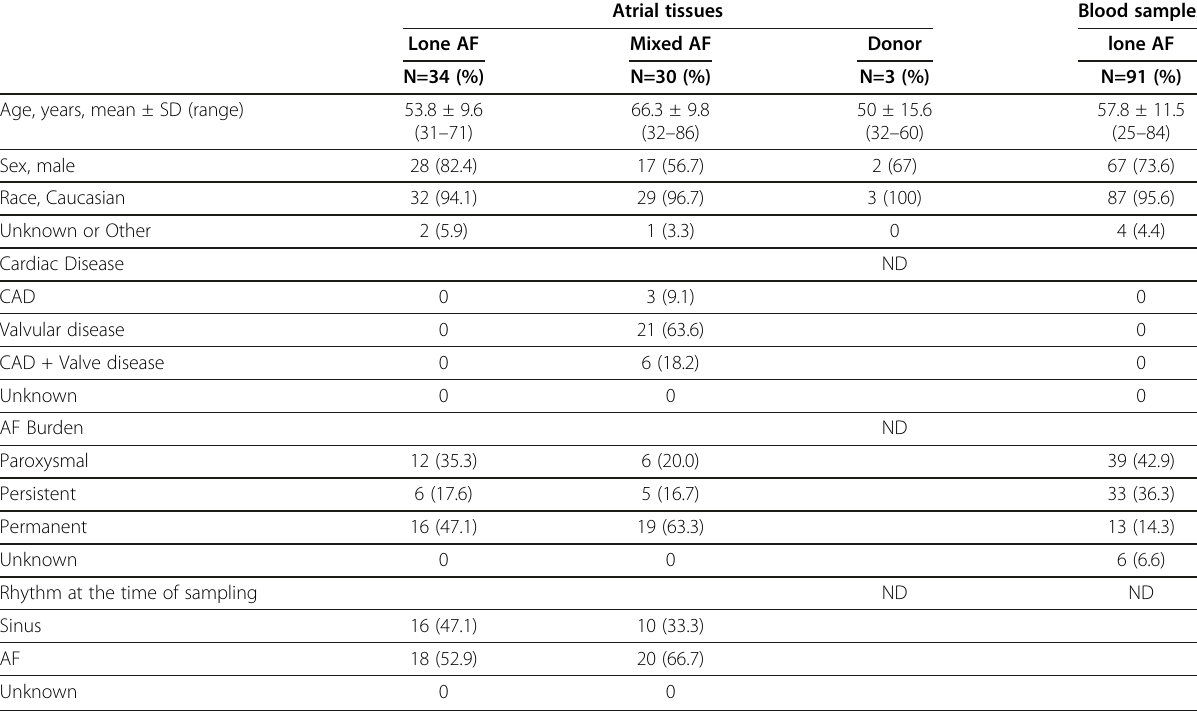
Table 1 Patient characteristics